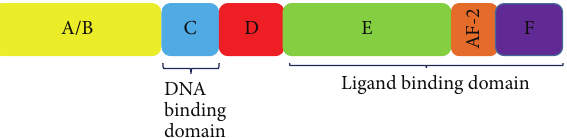
Figure 2: Main functional domains of nuclear PPARs. All three isotypes of PPAR have 4 main functional domains: A/B, which is the activation function 1 (AF-1); C, or DNA binding domain; D, which serves as a hinge between C and E/F; and E/F, which includes AF-2, a ligand binding dimerization transactivation domain.